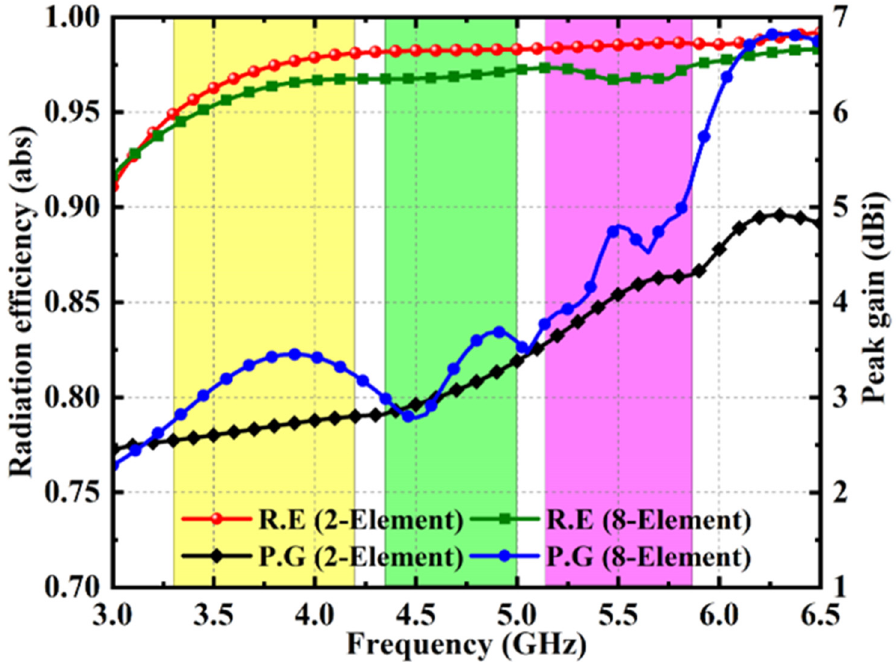
Figure 13. Radiation efficiency and peak gain response.